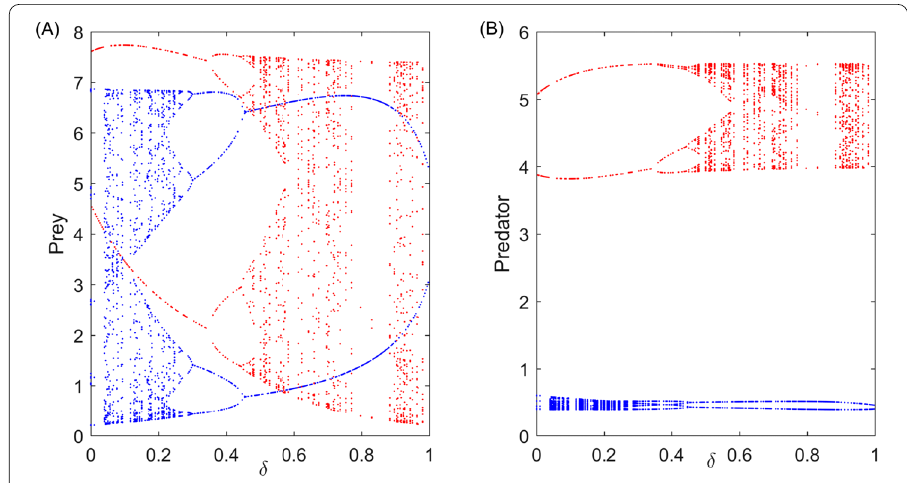
Figure 8 Bifurcation diagrams of model (17) with respect to bifurcation parameter δ . Parameter values are: r = 2.26, k = 13.6, α = 1.2, c = 0.37, ω = 0.25, D = 0.59, δ = 0.38, h = 7.8, λ 1 = 1.25, λ 2 = 5.5, θ = 1.65, T = 18. The red results are generated from initial values ( x 0 , y 0 ) = (2.7,2.5) and the blue results are generated from initial values ( x 0 , y 0 ) =